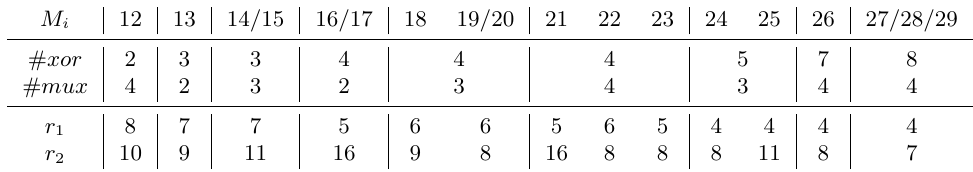
Table 4: Implementation cost and security properties of the candidate matrices for MC M